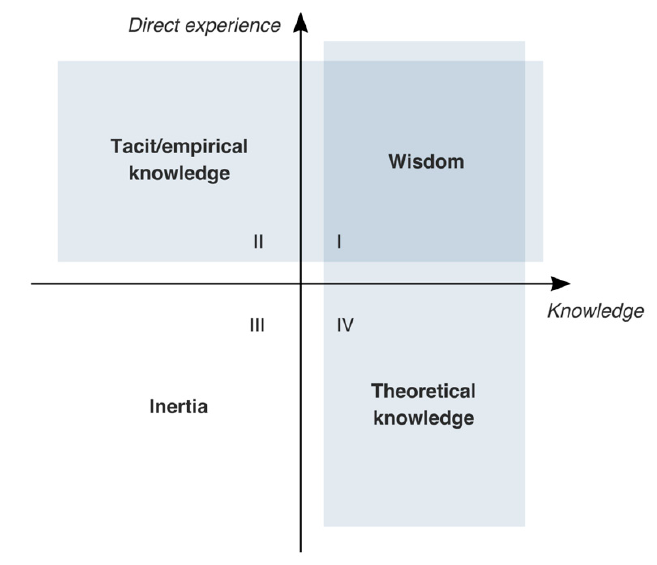
Figure 4. Experience-knowledge typology. 389